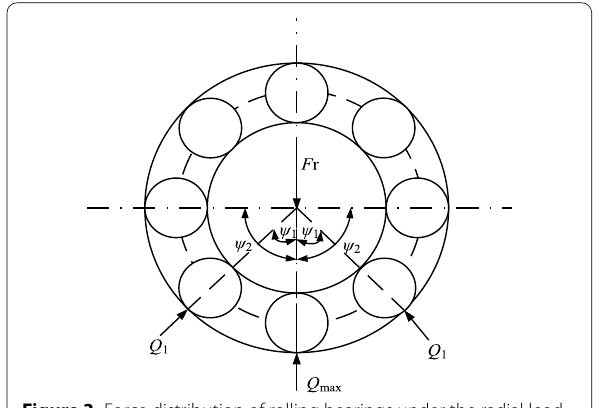
Figure 3 Force distribution of rolling bearings under the radial load